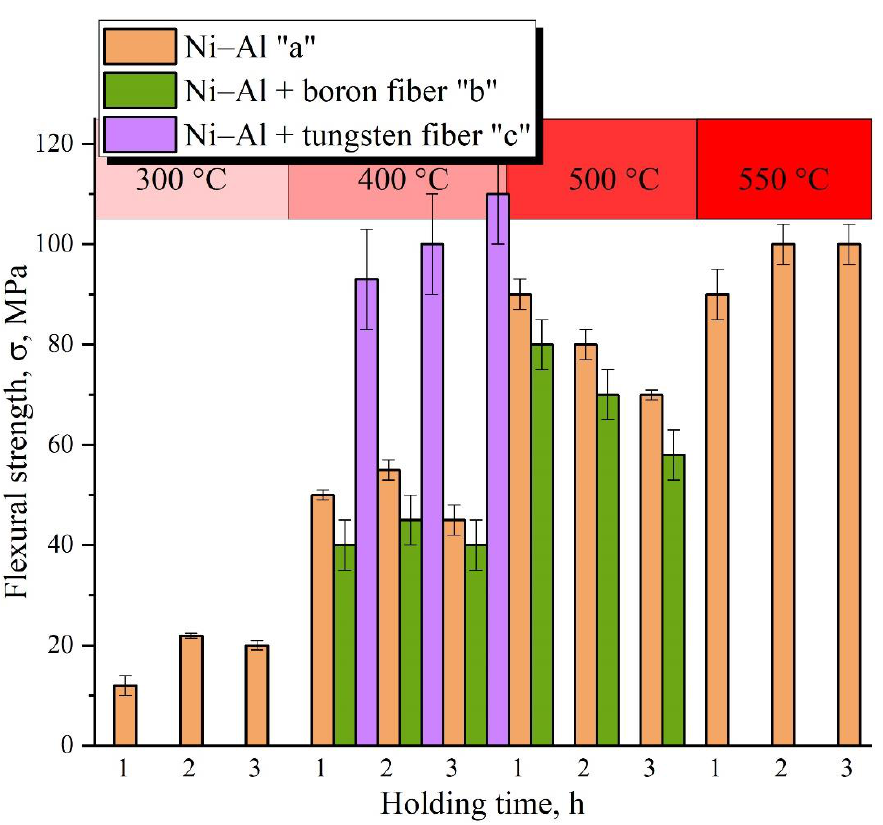
Figure 8. Flexural strength of specimens after HT.